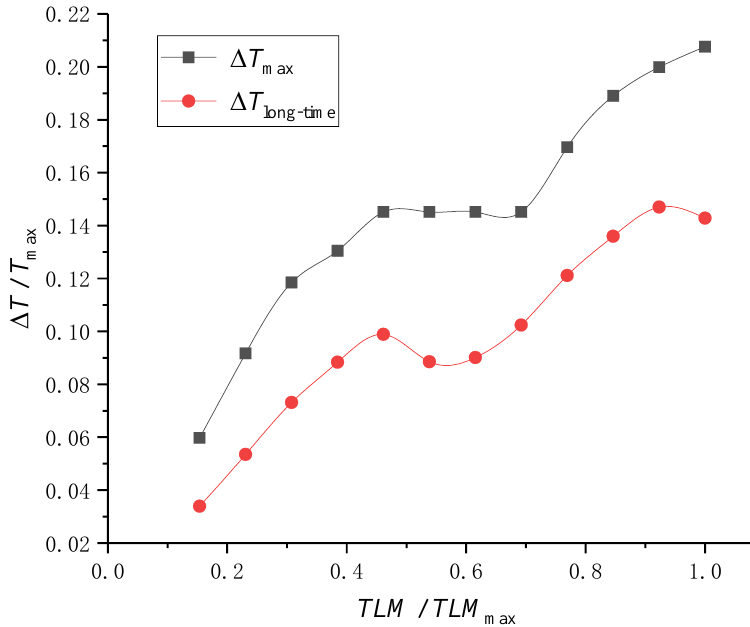
Figure 12. The temperature difference in different total leakage masses ( TLM ).